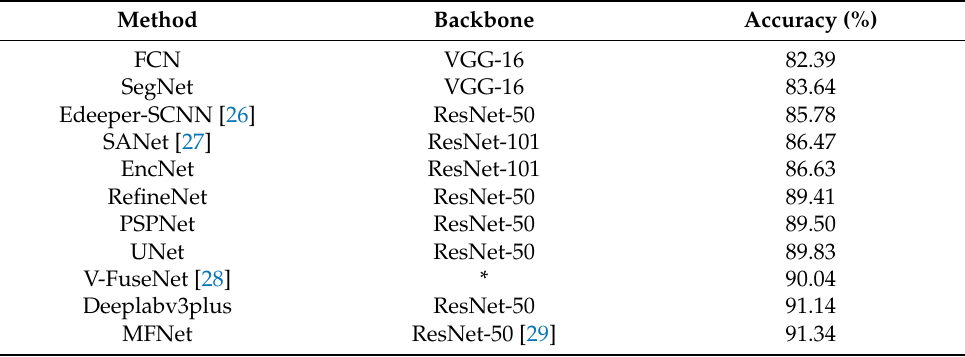
Table 1. Accuracy in the Vaihingen dataset (* defines the unknown